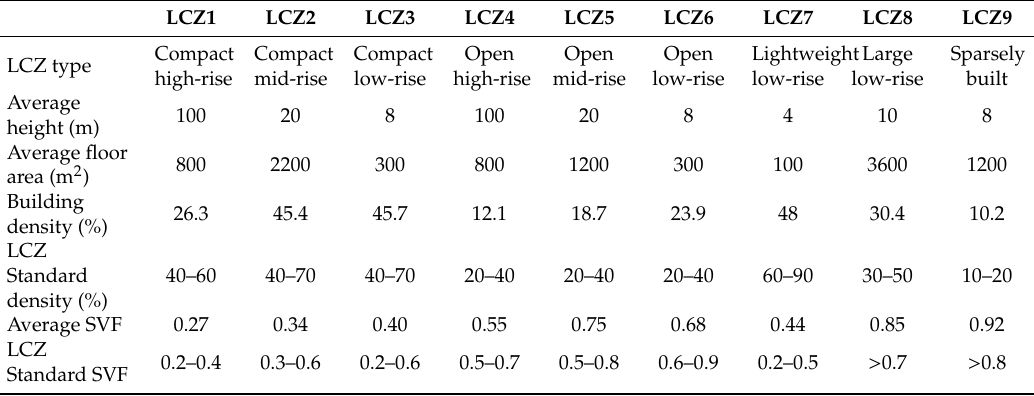
Figure 2. Satellite images of different districts in Nanjing. ( a ) Yile, Living community—compact mid-rise, LCZ2; ( b ) Xinjiekou, Commercial center—open high-rise LCZ4; ( c ) Menxi, Historical living zone—lightweight low-rise, LCZ7. Table 1. Parameters of the nine ideal city models (standards from Stewart et al. [30]).